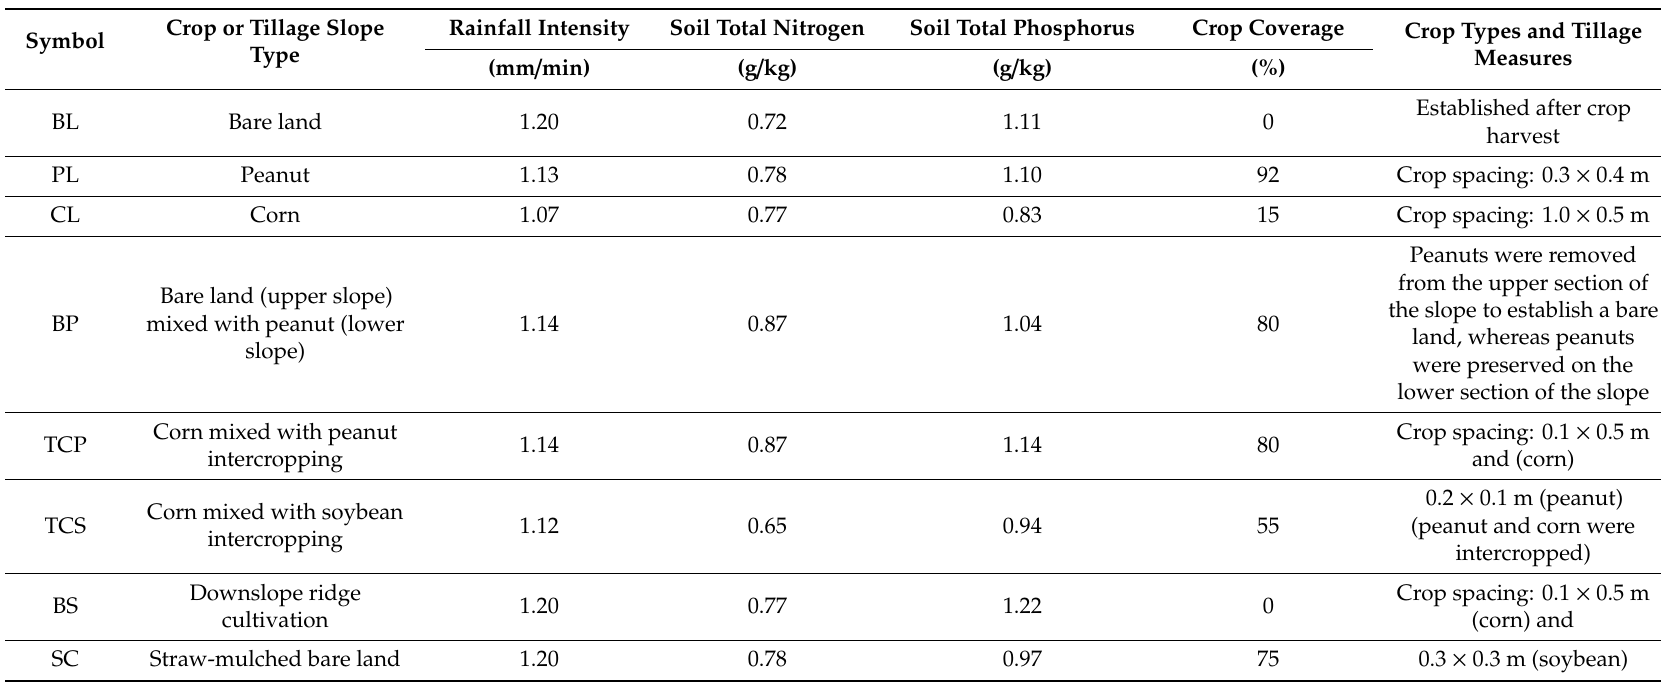
Table 1. Design of crop types and tillage measures for artificial rainfall